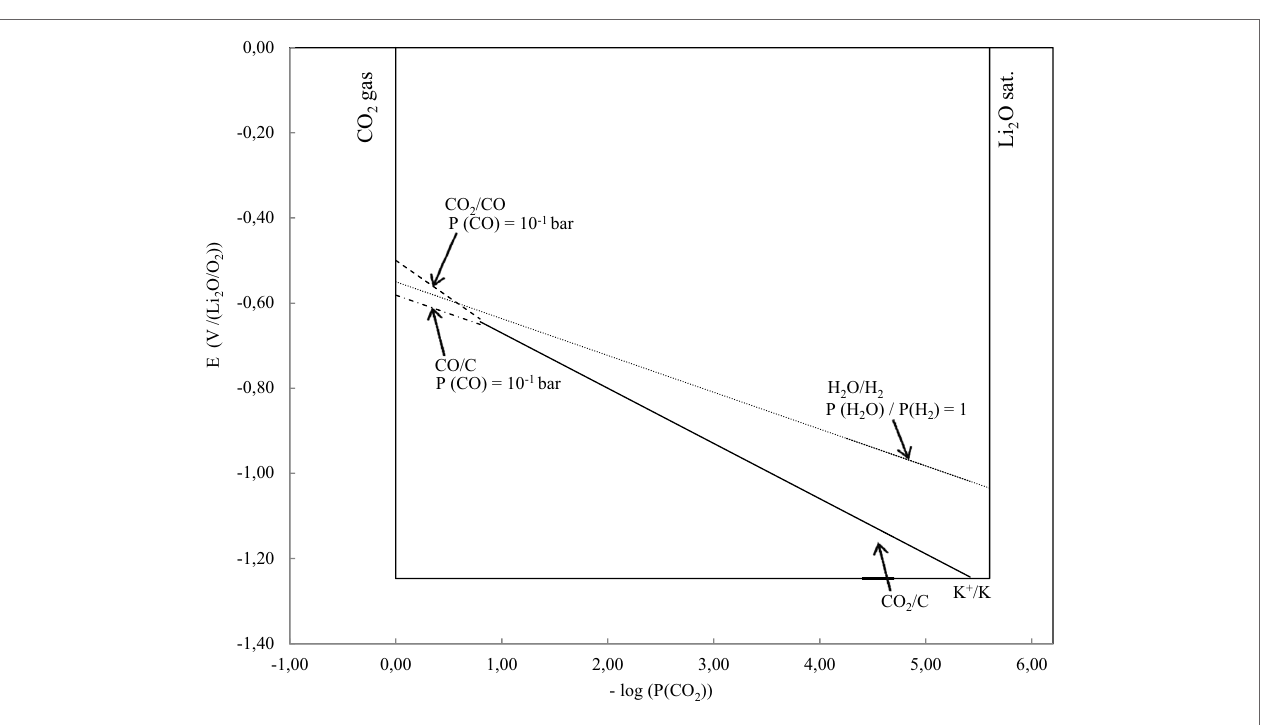
FiGURe 4 | influence of the temperature on the Li–Na–K (43.5–31.5–25 mol%) eutectic at 600°C for a H 2 O/H 2 ratio in pressure of 1 bar and a CO pressure of 10 − 1 bar .